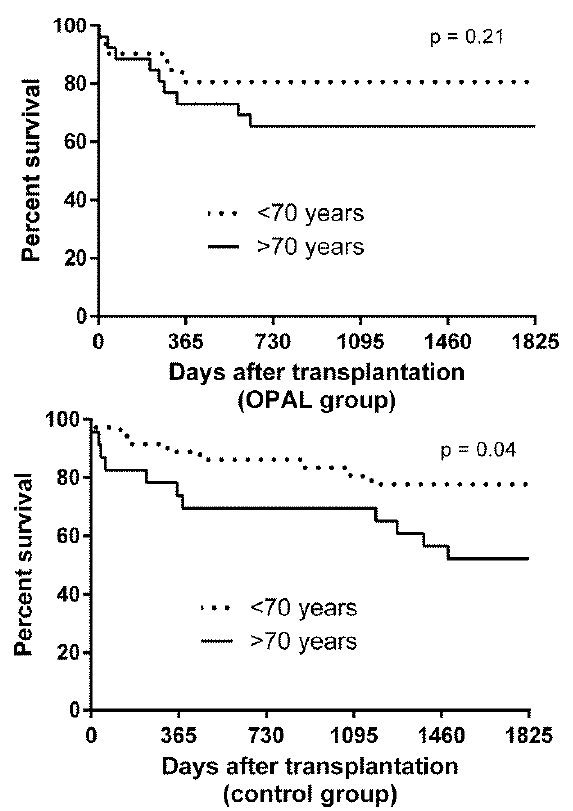
Figure 3. Five year patient survival in the treatment group (oxygen persufflation (OPAL)) and in the standard care group (control) according to recipient age (<70 years versus ≥70 years).